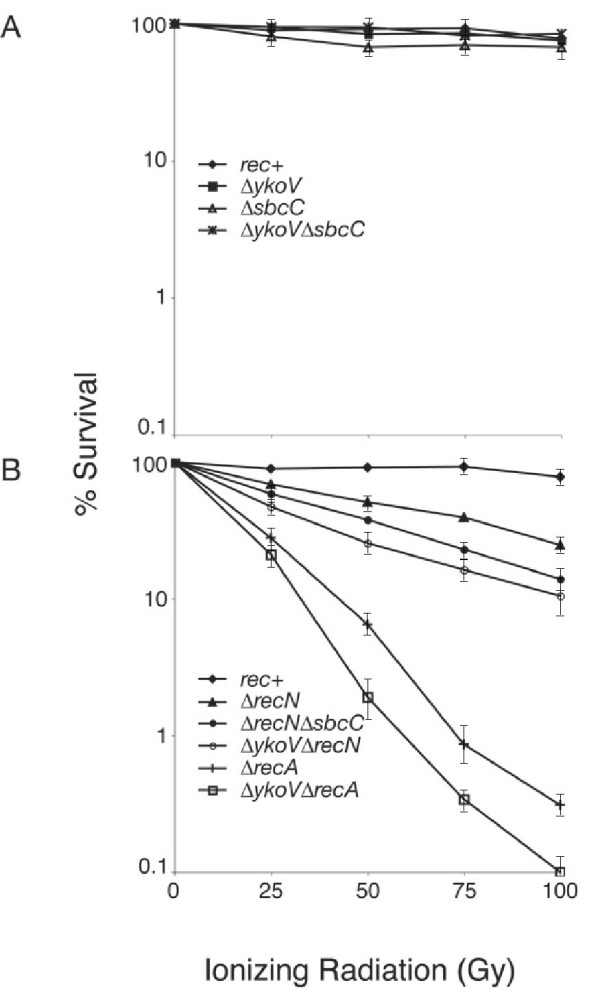
DNA repair sensitivity to γ-radiation of wild type (rec+) or of mutant cells grown to stationary-phase. Wild type cells and their isogenic derivatives (ΔsbcC, ΔykoV, ΔsbcC ΔykoV, ΔrecN, ΔsbcC ΔrecN, ΔykoV ΔrecN, ΔrecA, ΔykoV ΔrecA or ΔsbcC ΔrecA) were exposed to different doses of γ-radiation. At least three independent experiments were performed, bars denote standard deviations.